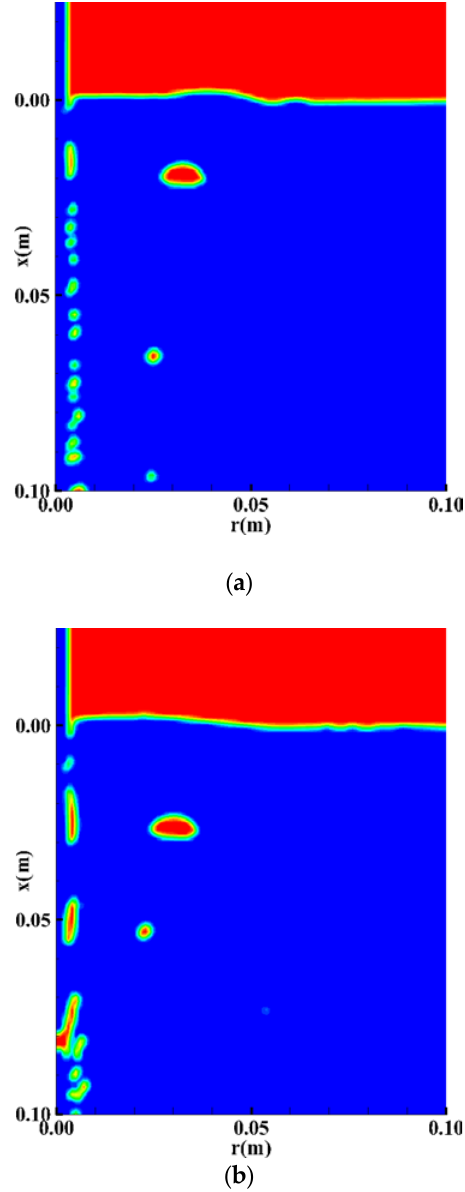
Figure 6. The jet bubbles and free surface deformation snapshots for ( a ) V 0 = 2.5 m/s and L 1 = 0.025 m, ( b ) V 0 = 3 m/s and L 1 = 0.025 m.